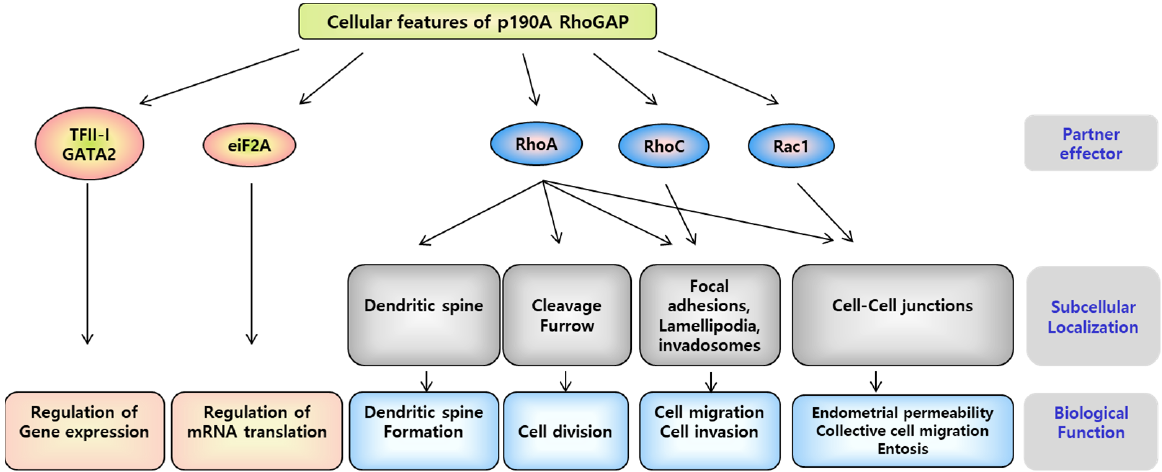
Figure 2. Role of P190A RhoGAP in various cellular processes. The interaction between P190A and p120-catenin at the cell-cell junction inhibits RhoA activity. CRAD (catenin-RhoGAP-association do- main), a C-terminus domain of p120-catenin, interacts with P190A. CRAD depletion in p120-catenin of endothelial cells affects the transmembrane transduction of P190A and regulates endothelial per- meability by increasing RhoA and decreasing the Rac1 signal. The crossover between cell-cell con- tact and cell-matrix adhesion is produced by the P190/P120-catenin complex to spatially regulate RhoA activity. The transient decrease in P190A levels during late mitosis in the cell cycle finely regulates RhoA activity required for cell division; P190A is also required to regulate spindle for- mation [23].